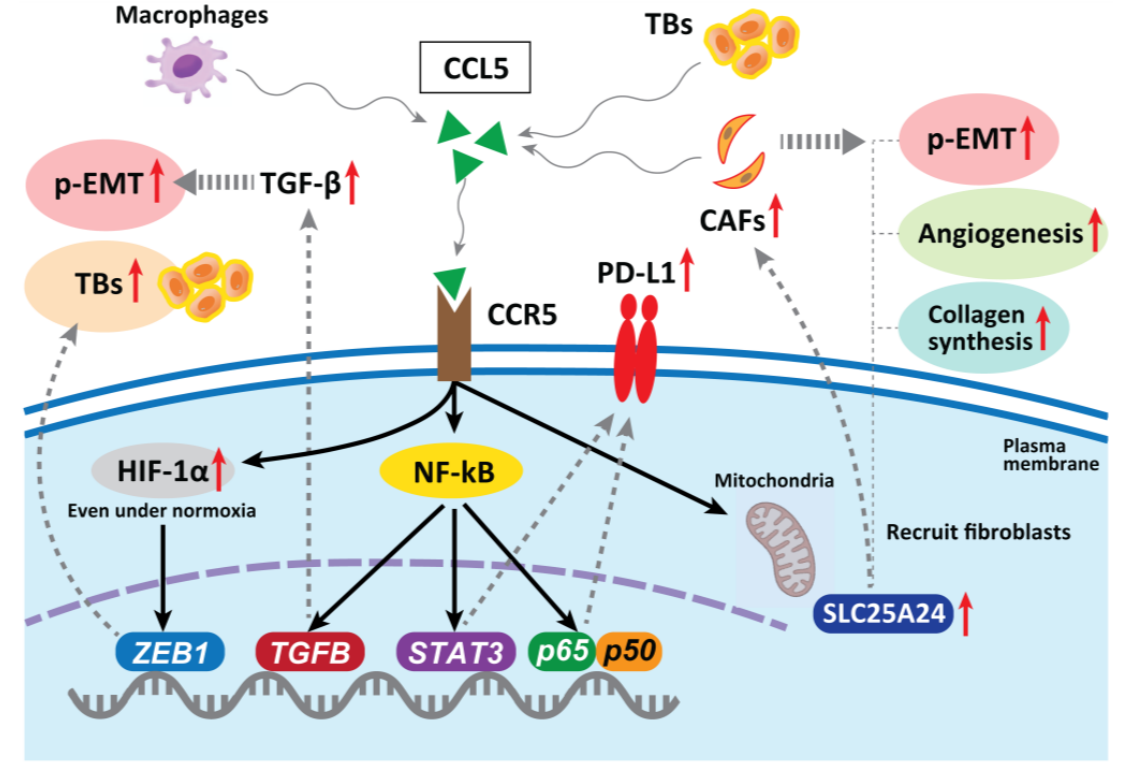
Figure 3. In hepatocellular carcinoma, CAF-derived CCL5 promotes metastasis by binding to specific receptors, CCR5, and stabilizing HIF-1 α under normoxia, upregulating one of the EMT genes ZEB1 and promoting TB development. In CRC, CCL5 blockade reduces tumor growth, decreases migration of tumor cells, reduces metastases, and decreases infiltration of T regs in the tumor. CCL5 can stabilize PD-L1 in vitro and in vivo. CCR5 can also modulate TGF- β activity, which subsequently promotes an EMT. TB cells secrete high levels of CCL5, which recruits fibroblasts through CCR5– SLC25A24 signaling and leads to the development of a characteristic fibroblast cluster around TB cells at the invasive front of CRC. This further facilitates tumor angiogenesis and collagen synthesis, recruitment of CAFs, and promotes malignant progression. CCR5 can also modulate TGF- β activity, which subsequently promotes an EMT and increases tumor cell migration via the activation of the NF- κ B